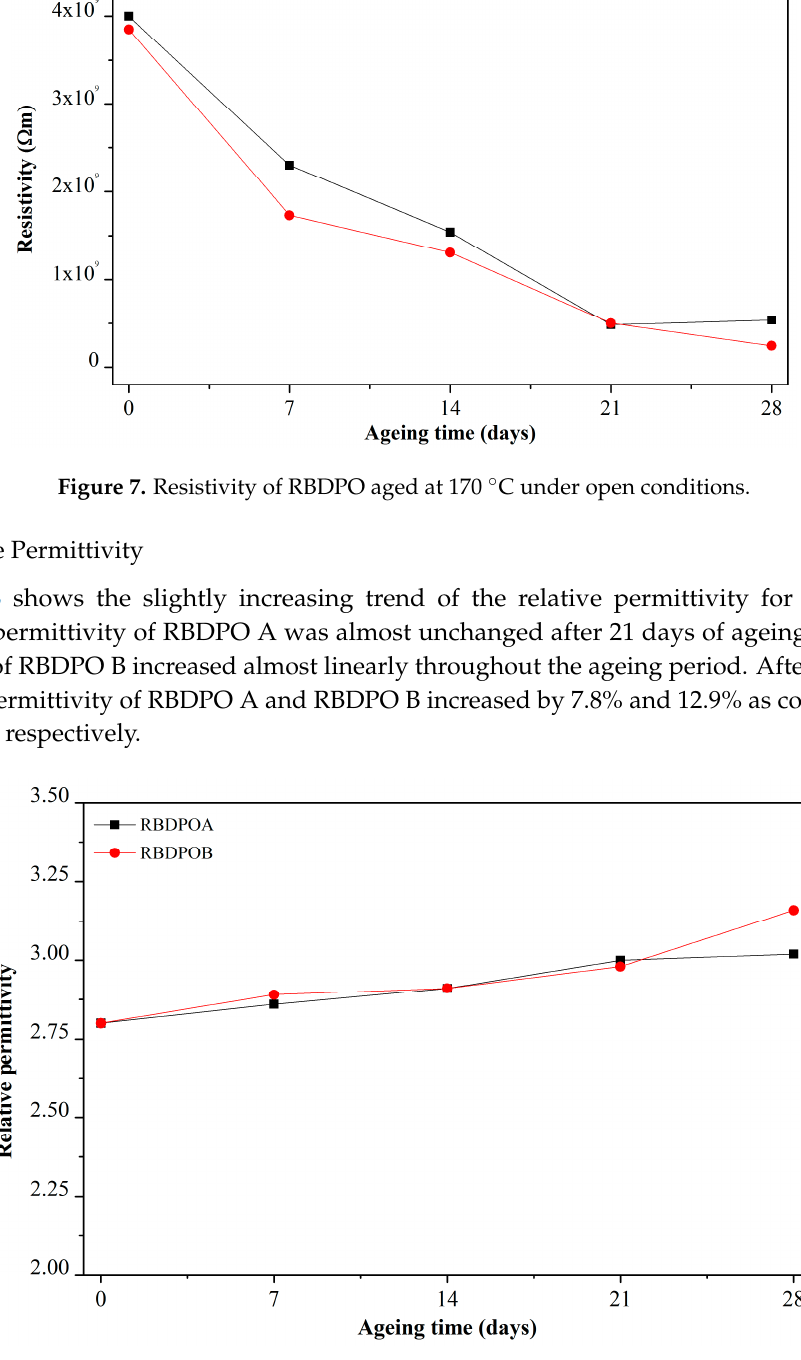
Figure 8. Relative permittivity of RBDPO aged at 170 °C under open conditions.